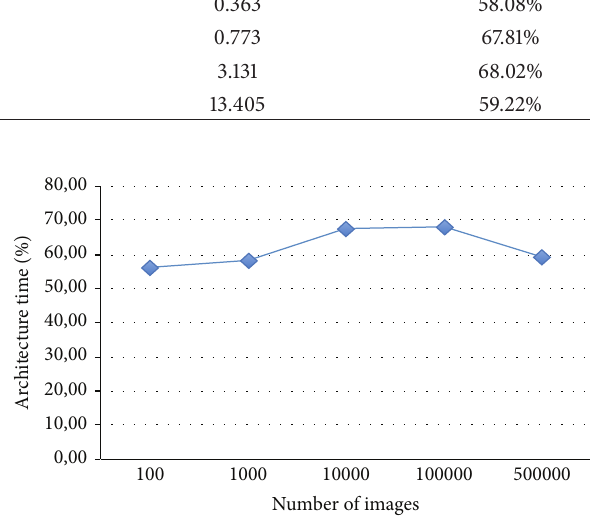
Figure2:Percentageofarchitecturetimewithrespecttothenumber of images, indexing phase.